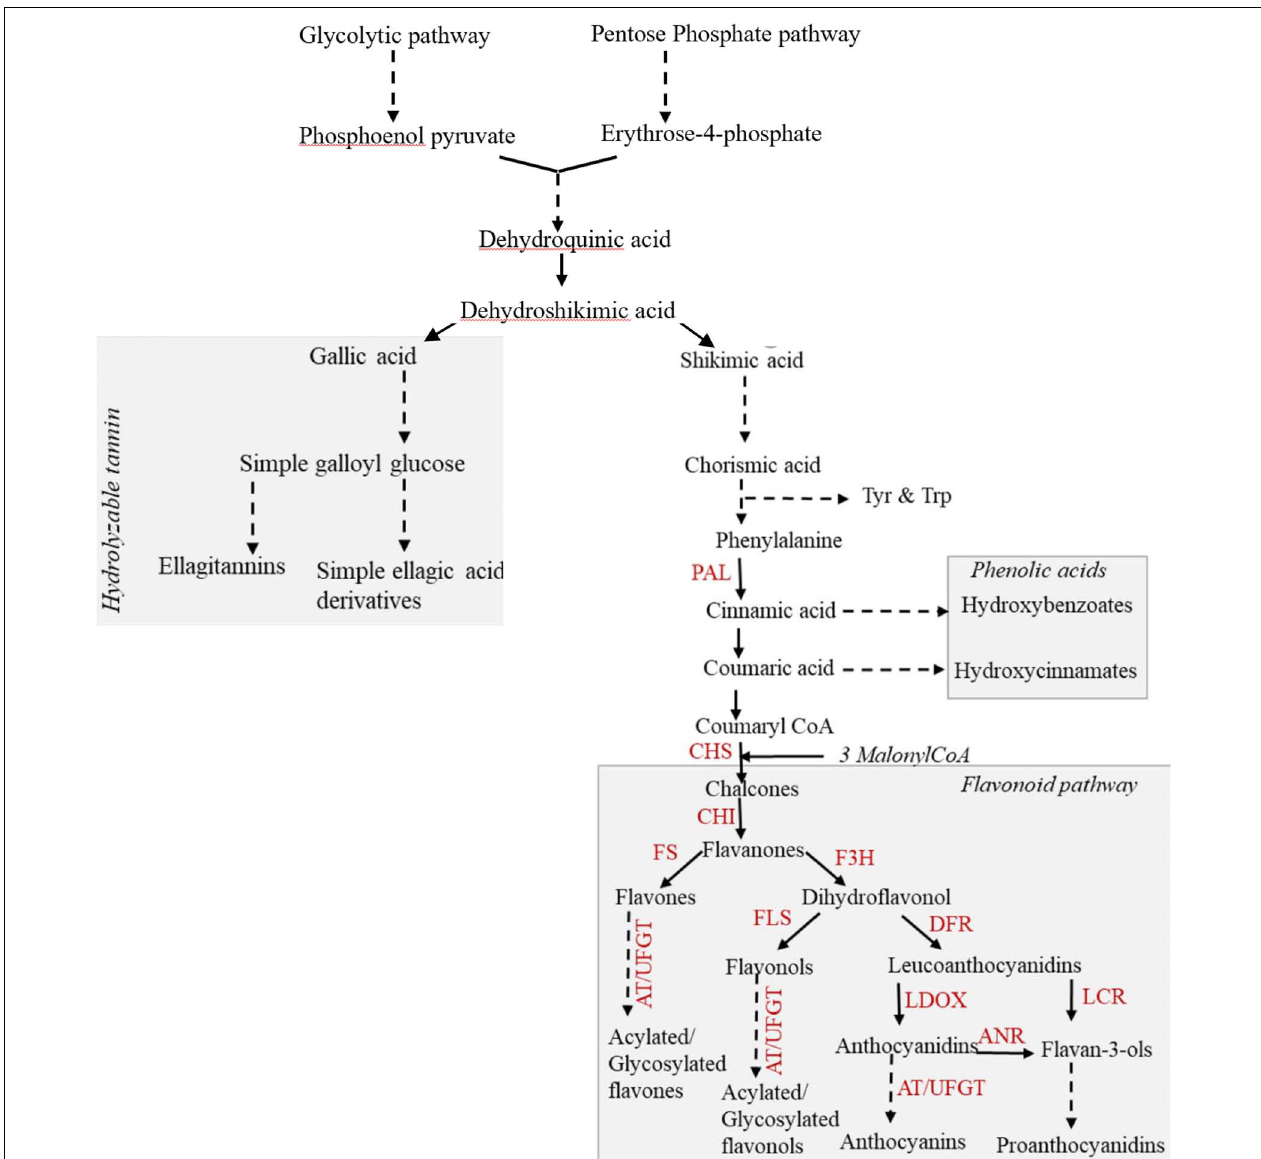
FIGURE 1 | Scheme of the biosynthesis of phenolics in plants focusing on the flavonoid classes and the potential trade-off between the HTs and flavonoids. Discontinuous lines indicate multiple steps that are not all included in the figure. Phenolic acids and flavonoids together constitute the phenylpropanoids. The key enzymes that regulate this biosynthesis are indicated: PAL, phenylalanine ammonia lyase; CHS, chalcone synthase; CHI, chalcone isomerase; FS, flavone synthase; F3H, flavanone3-hydroxylase; FLS, flavonol synthase; DFR, dihydroflavonol 4-reductase; LDOX, leucoanthocyanidin dioxygenase; LCR, leucoanthocyanidin reductase; ANR, anthocyanidin reductase; AT, acyltransferase; UFGT, UDP flavonoid